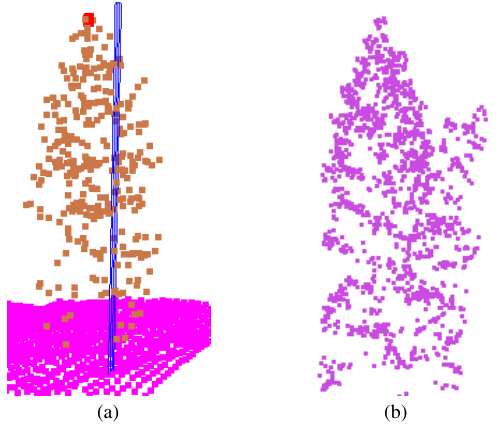
Figure 3. (a) Discrepancy between tree position from field inventory (blue bar) and true tree top (red cylinder) in Dataset (I). (b) Erroneous tree cluster from Dataset (II), containing part of adjacent